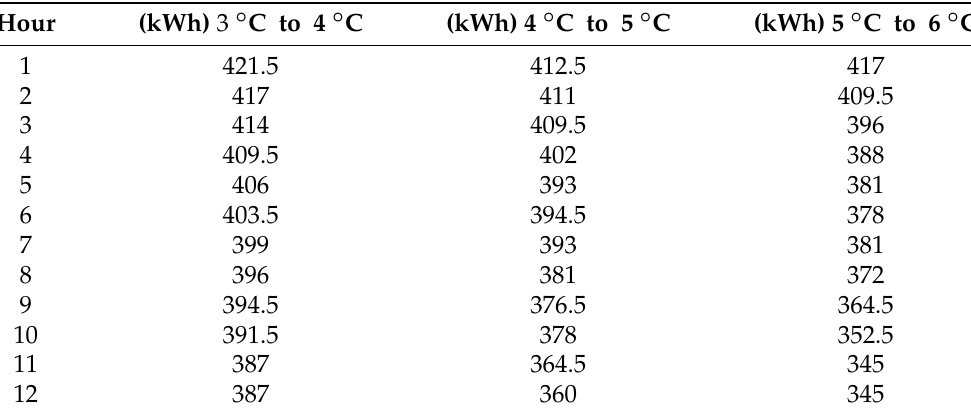
Table 1. HVAC Flower Greenhouse Flexible Consumption